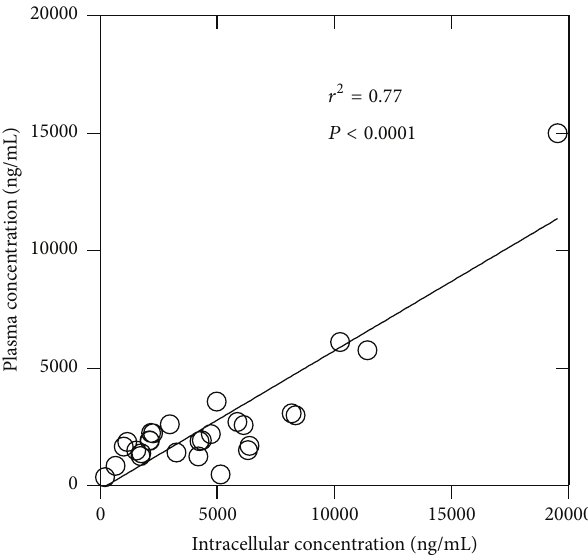
Figure 1: Relationship between intracellular and plasma concentra- tions for